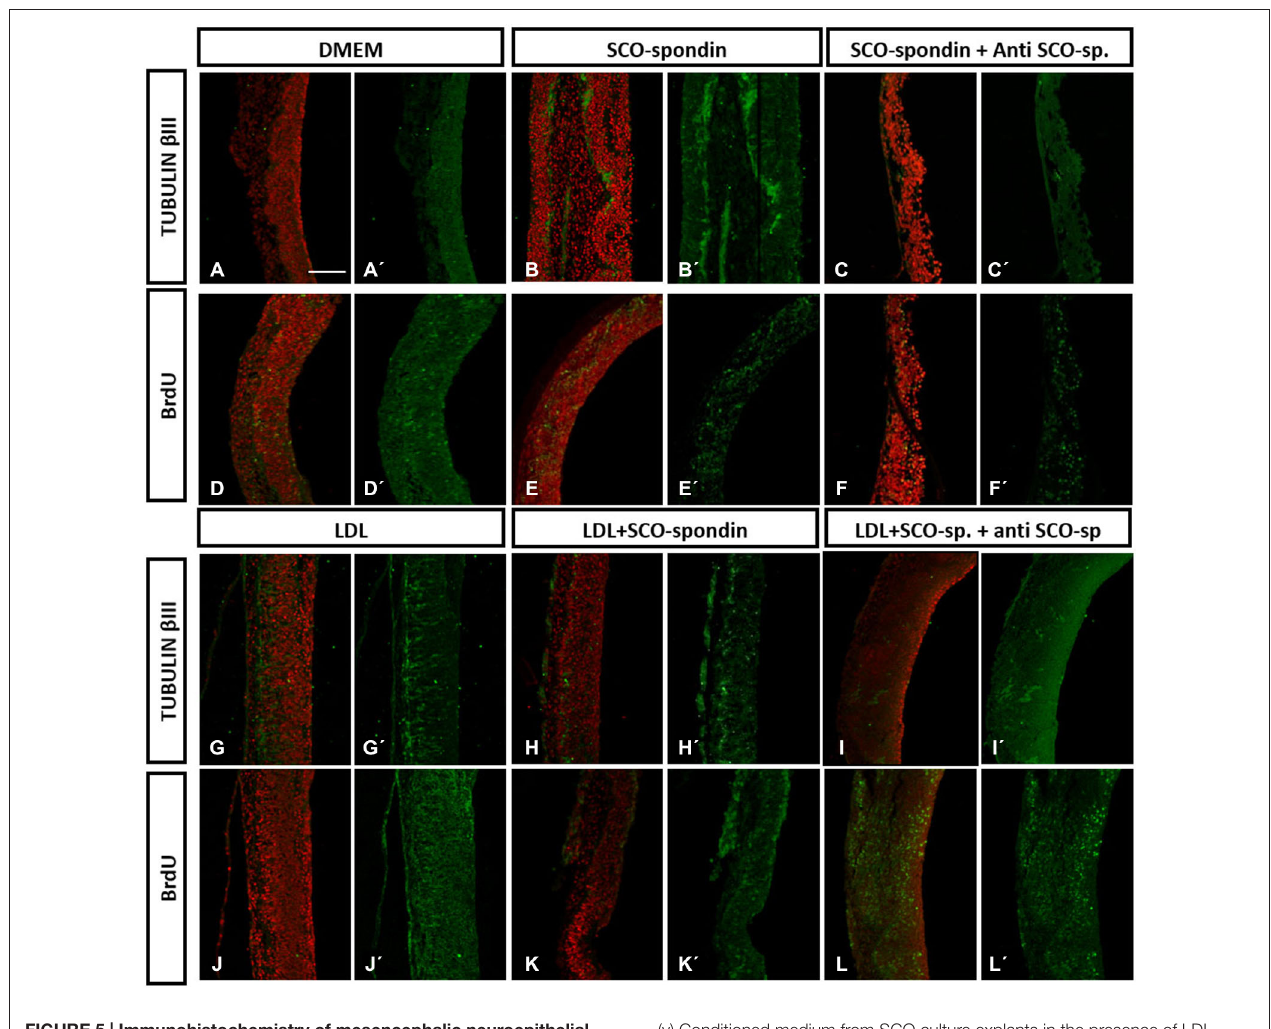
FIGURE 5 | Immunohistochemistry of mesencephalic neuroepithelial explants under various experimental conditions . Optic tectum explants from HH20 embryos cultured for 24 h in the presence of: (i) DMEM as a negative control (A,D) ; (ii) Conditioned medium from SCO culture explants (B,E) ; (iii) Conditioned medium from SCO culture explants plus anti-SCO-spondin antibodies (C,F) ; (iv) DMEM in the presence of LDL (G,J) ;